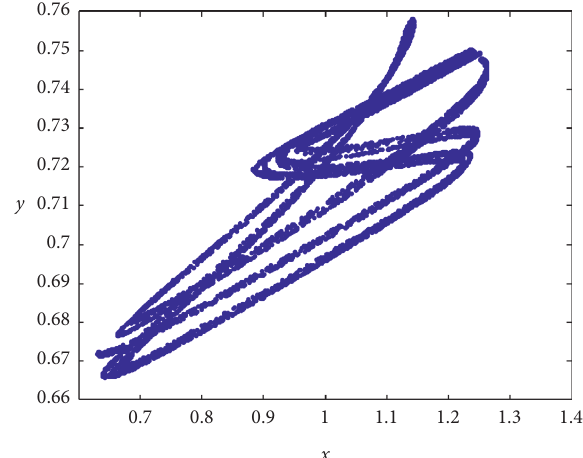
Figure 6: x – y phase diagram which denotes that the system is chaotic when α � 0.05.